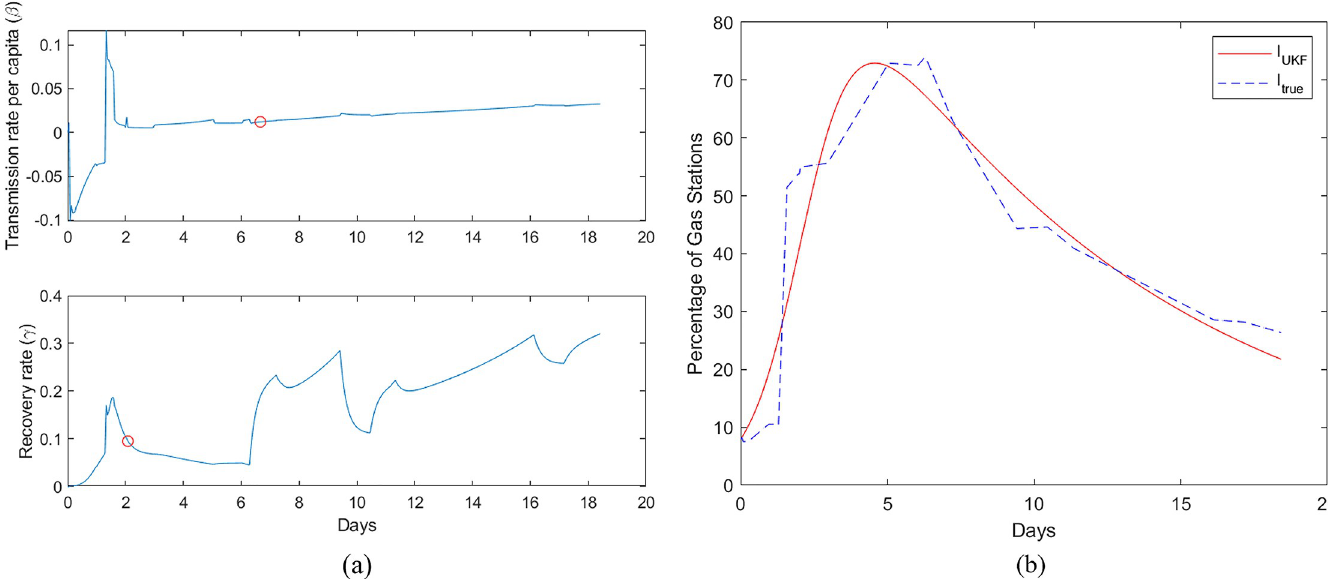
Fig 4. (a). β and γ rates estimated from Gasbuddy data for each time step (dt) for Wilmington during Hurricane Florence. The red circle represents the β and γ values used to plot I UKF in 4(b). (b) Continuous time Invariant data of % empty fuel stations (I(t)). Computed data from the best fit β and γ constant parameters, and the empirical data is shown for Wilmington during Hurricane Irma. https://doi.org/10.1371/journal.pone.0229957.g004 marked in Figs 3(A) and 4(A) for the two cases. Fig 3(B) shows the empirical fuel shortage data and the estimated continuous data with the constant β and γ values for Naples-Fort Myers. A similar plot for Wilmington during Hurricane Florence is shown in Fig 4(B). In both cases, we can observe that the estimated data for the continuous time invariant SIR model show close resemblance to the empirical fuel shortage data. The continuous time invariant model SIR data for the remaining cities affected by Hurri- canes Irma and Florence were computed in a similar way. The best fit values of β , γ and the basic reproduction number (R0) for all of the cities are tabulated in Table 2. The UKF estima- tion of β and γ values were unique to each city. While the values of β vary depending on the impact of Hurricane evacuation in the different cities, the evolution of β follows a similar trend for all cities as shown in Fig 5. The similarity of γ values for different cities is indicative of the similarity in the recovery period for the different cities affected by Hurricane Irma. In the case of Hurricane Florence the slow moving nature of the storm and the difference in the infrastructure, in the affected communities resulted in the variation in the recovery periods.